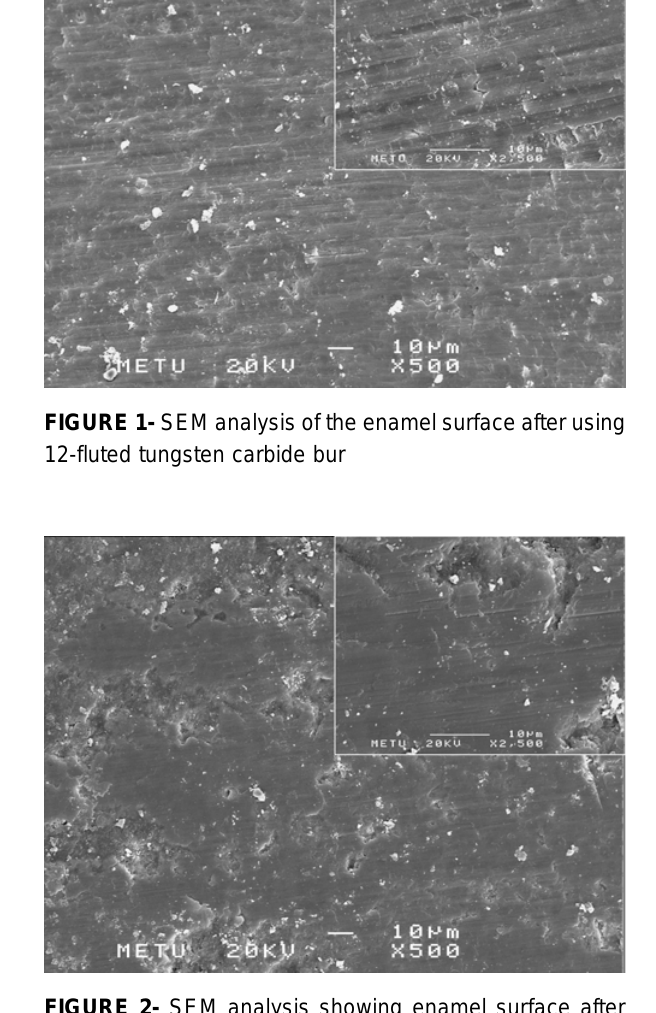
FIGURE 2- SEM analysis showing enamel surface after using 30-fluted tungsten carbide bur for surface cleaning